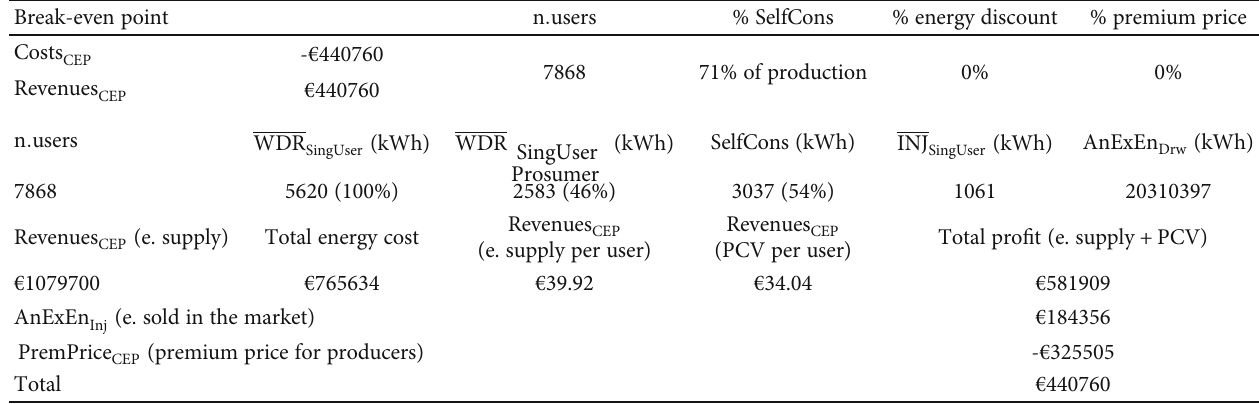
Figure 1: CEP costs, revenues, and break-even point 2016. Table 6: Cost, revenues, and users ’ distribution — 2017 (a).